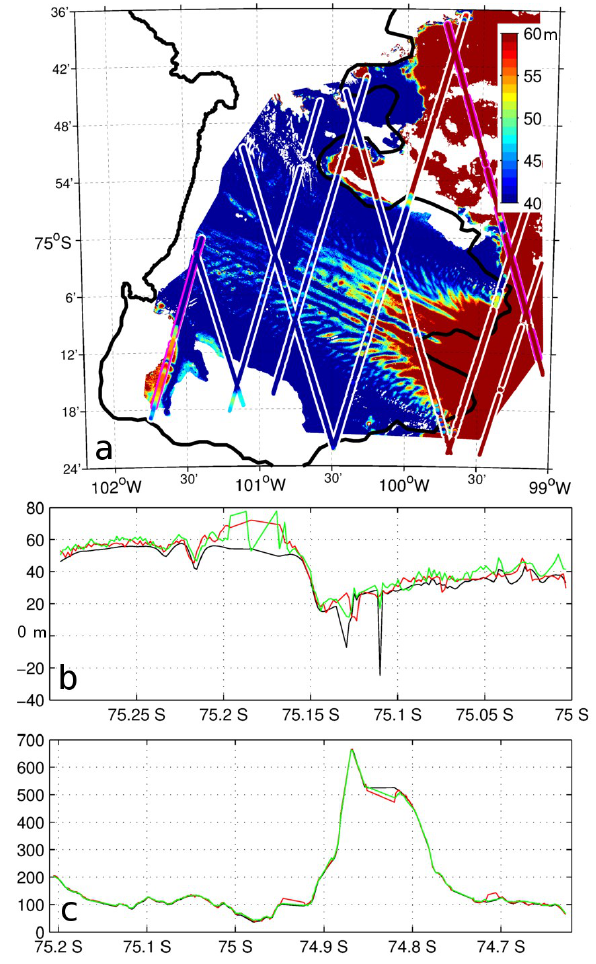
Fig. A1. (a) Surface elevation measured in 13 March 2008 by the SPIRIT mission. Overlaid white-circled-coloured dots show 2008 along-track ICESat satellite observed surface elevation. Magenta- circled dots indicate the track-lines selected in (b) and (c) that were measured within 5 days of the SPIRIT DEMs, and covered more slowly evolving or grounded part of the glacier and part of the Hud- son mountains. (b) The black line shows along-track surface eleva- tion measured by ICESat in 13 March 2008 near the southern part of the glacier calving front. Red and green lines shows surface el- evation along the same line interpolated from SPIRIT DEMs taken in 5 January and 18 March 2008, respectively, before calibration is applied. (c) Same as (b) , but for the easternmost selected ICESat line measured in 10 March 2008 and covering grounded ice.